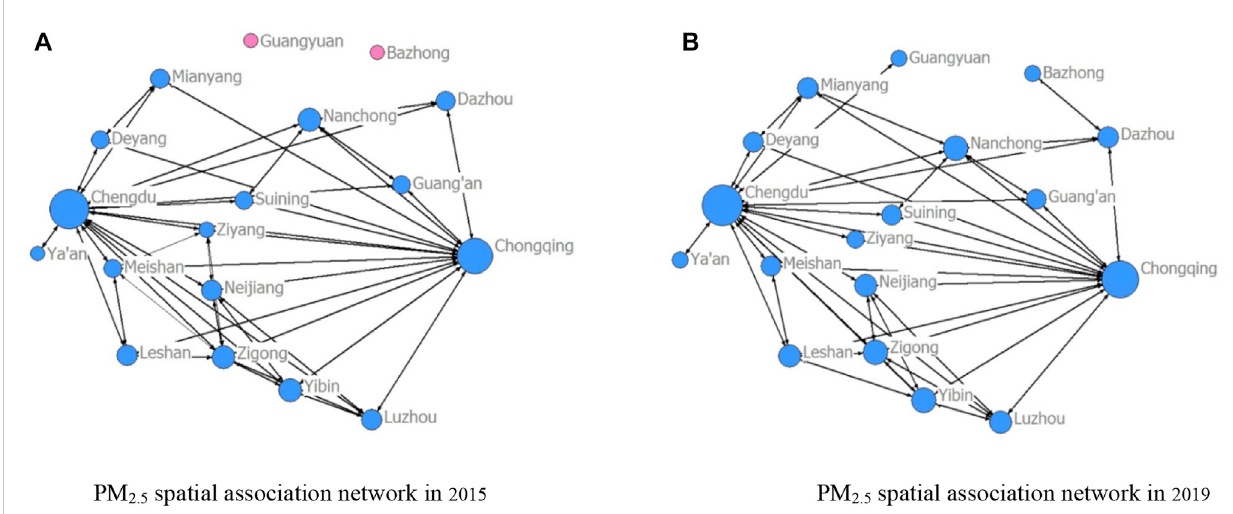
FIGURE 6 Spatial association network ofPM 2.5 pollution inSCB (Thesize ofpoint ispositivelyproportional to thedegree). (A) PM 2.5 spatial association network in 2015 (B) PM 2.5 spatial association network in 2019.